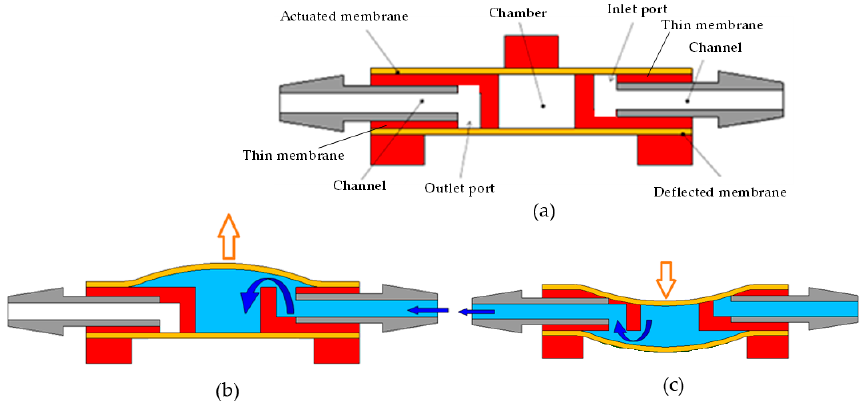
Figure 2. ( a ) Schematic front view of valveless pump and the working principle of the ( b ) suction process and ( c ) compression process.